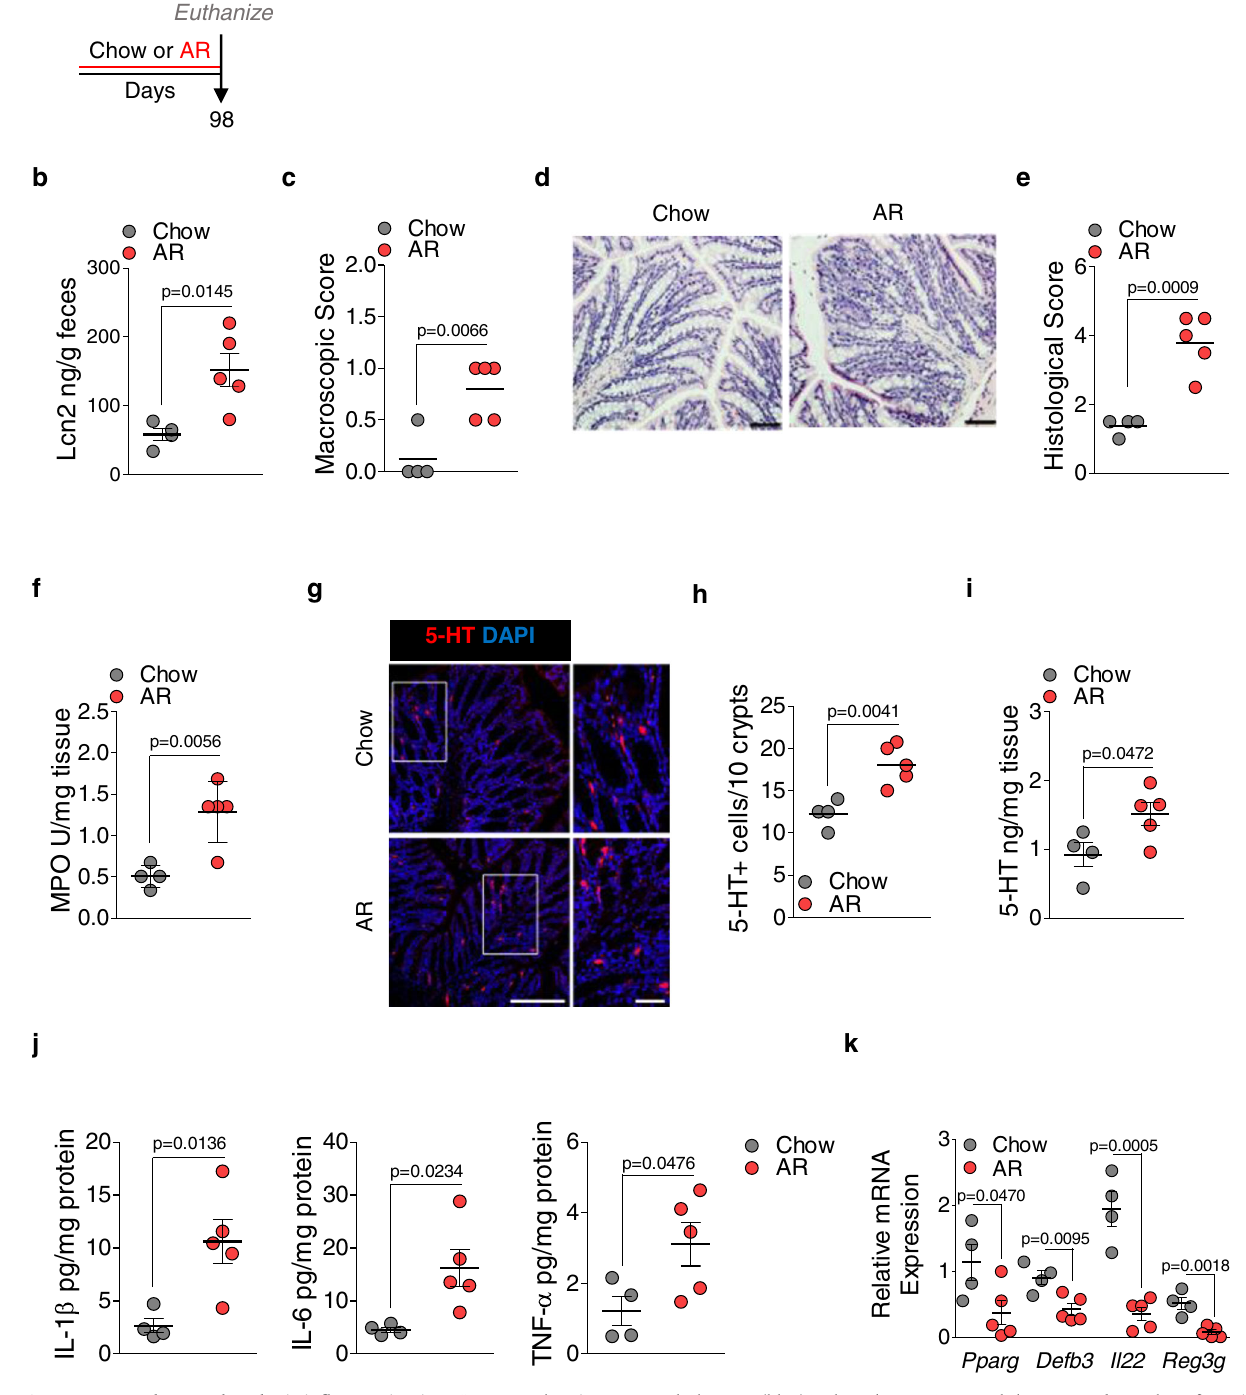
Fig. 3 | AR promotes low-grade colonic in fl ammation in naïve C57BL/6 mice. Naïve C57BL/6 mice were either fed normal chow diet or exposed to 100ppm AR via diet for 14 weeks (98 days). a Schematic illustration of the experimental design b Fecal LCN2 levels. c Macroscopic score. d Representative images of H&E-stained colon sections; scale bar: 50 µ m. e Histological score. f Colonic MPO levels. g Representative images of immuno fl uorescence (IF) staining for 5-HT (red) and